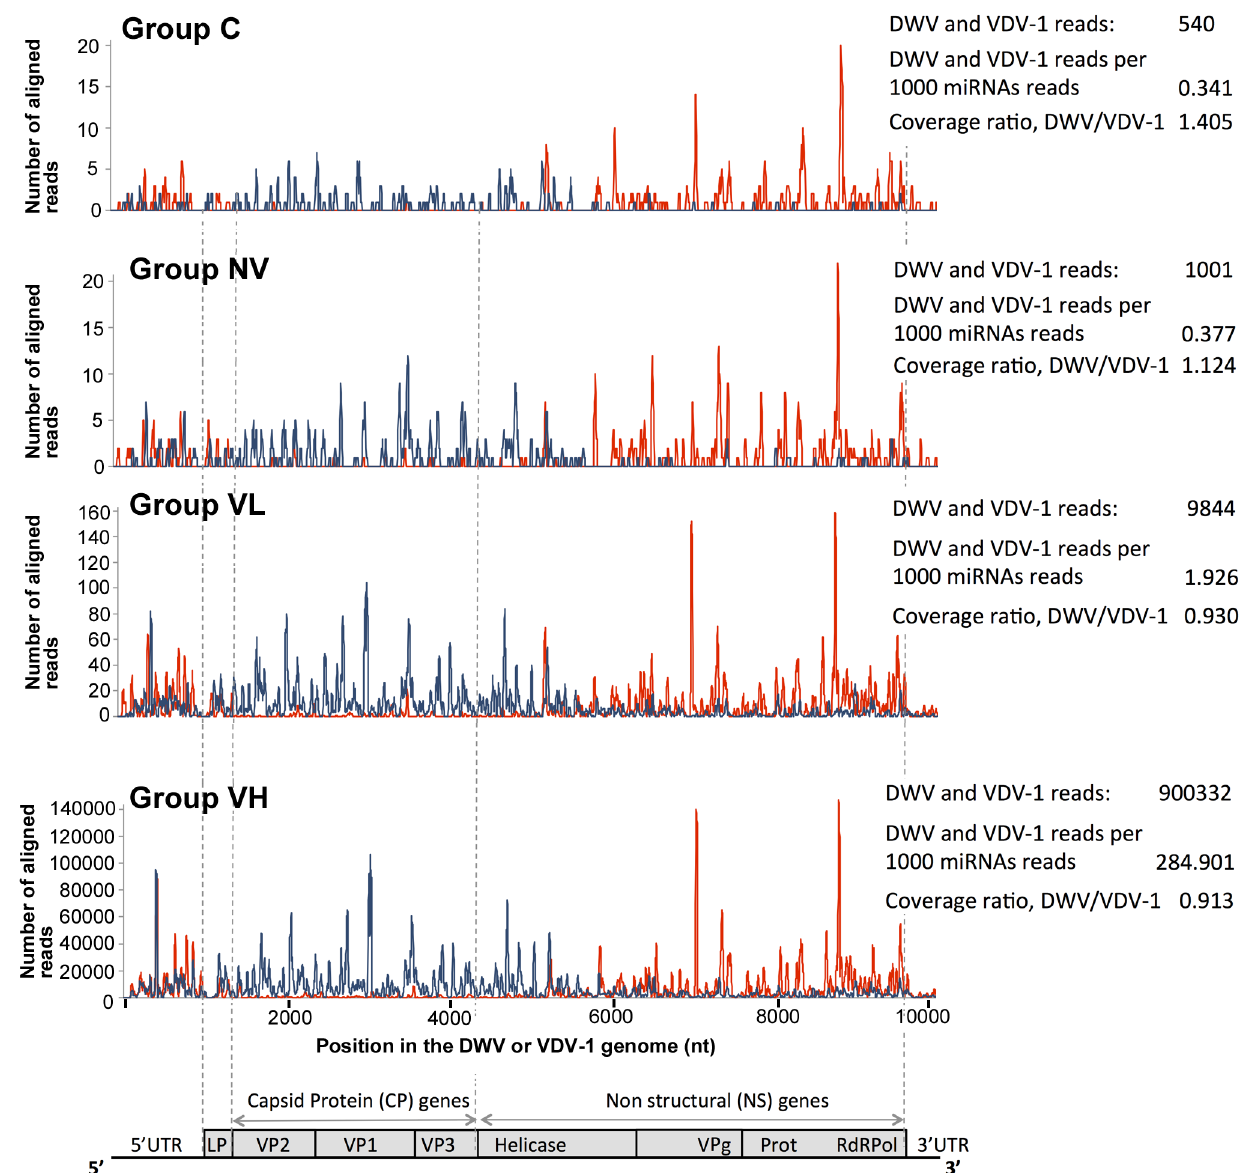
Figure 3. High-throughput sequencing of the honeybee small RNA libraries. The graphs show depth of coverage at the genomic loci of DWV (red) and VDV-1 (blue). A statistical summary of the reads is given to the right of each group. Only reads unambiguously aligning to DWV or VDV-1 were used (GenBank Accession numbers GU109335 and AY251269 respectively) with no mismatches being tolerated in the 18 nt. seed.